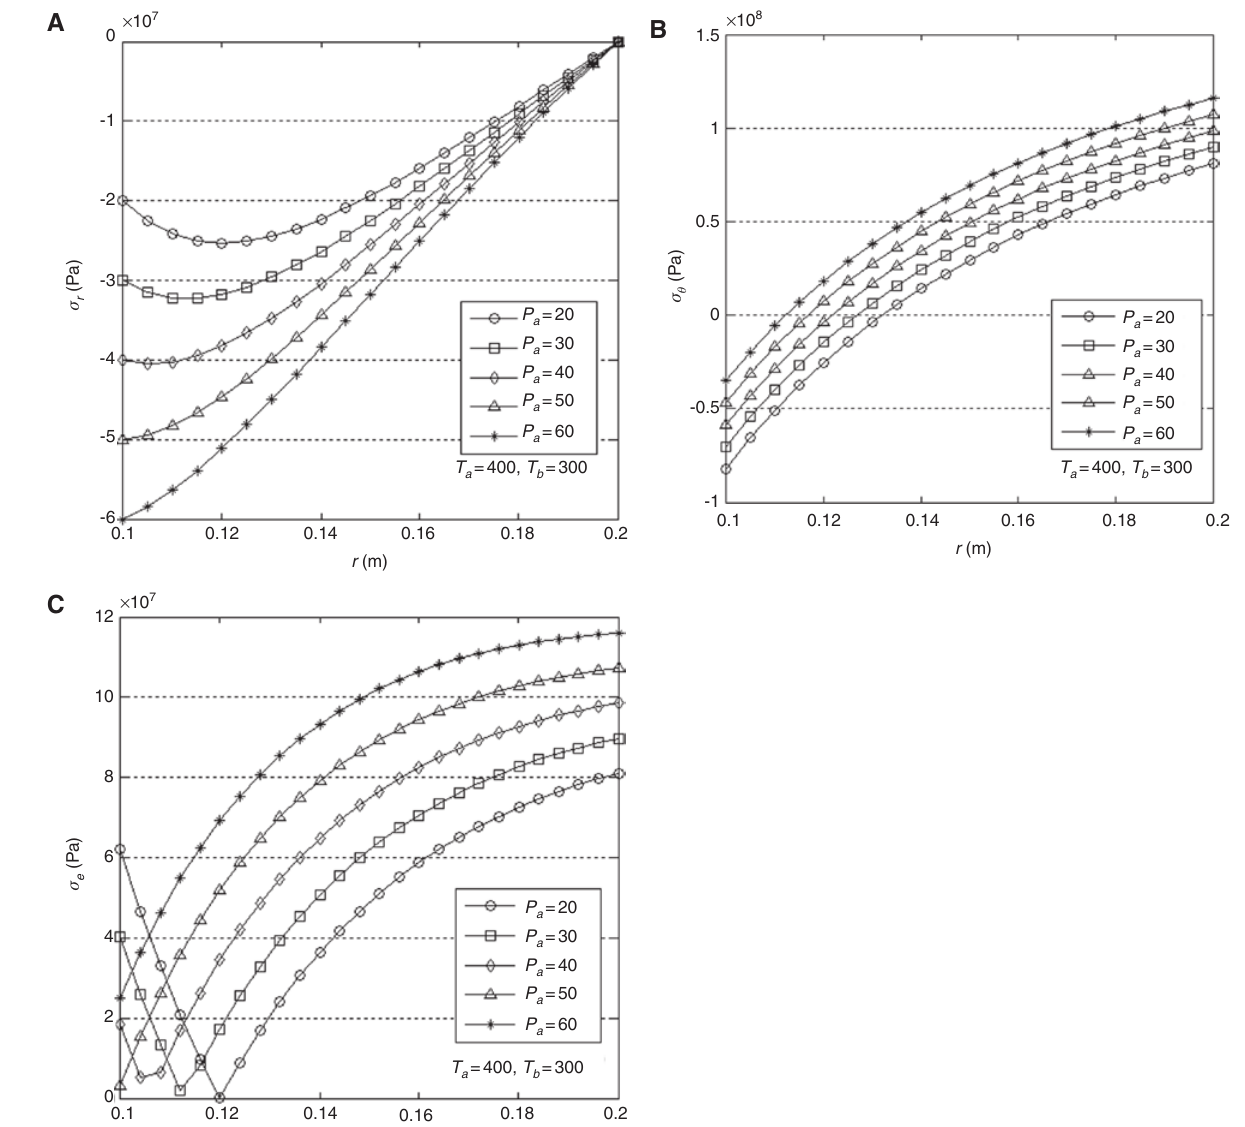
= 400 ° K, T = 300 ° a b